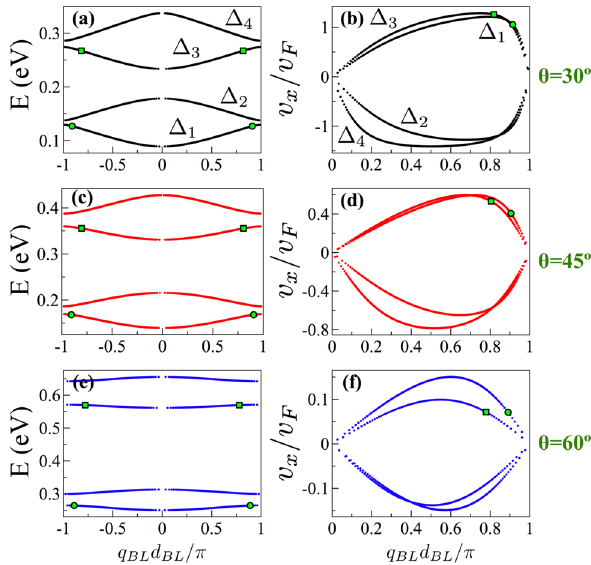
Figure 14. The same as Fig. 13, but for BPGGSLs. The biperiodic superlattice parameters are: V 0 = 0.1 eV, d B = d W 2 = 50 a and d W 1 = 60 a . (cid:31) 1 , (cid:31) 2 , (cid:31) 3 and (cid:31) 4 represent the first, second, third and fourth electron energy minibands, respectively. The points and squares in color correspond to transparent